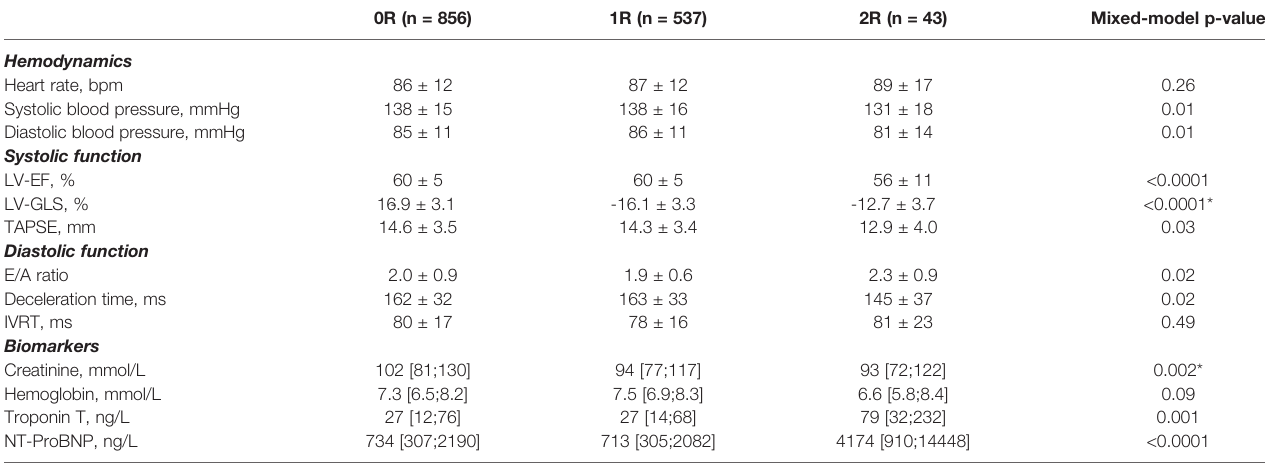
TABLE 2 | Hemodynamics, myocardial function, and serological markers according to rejection group.